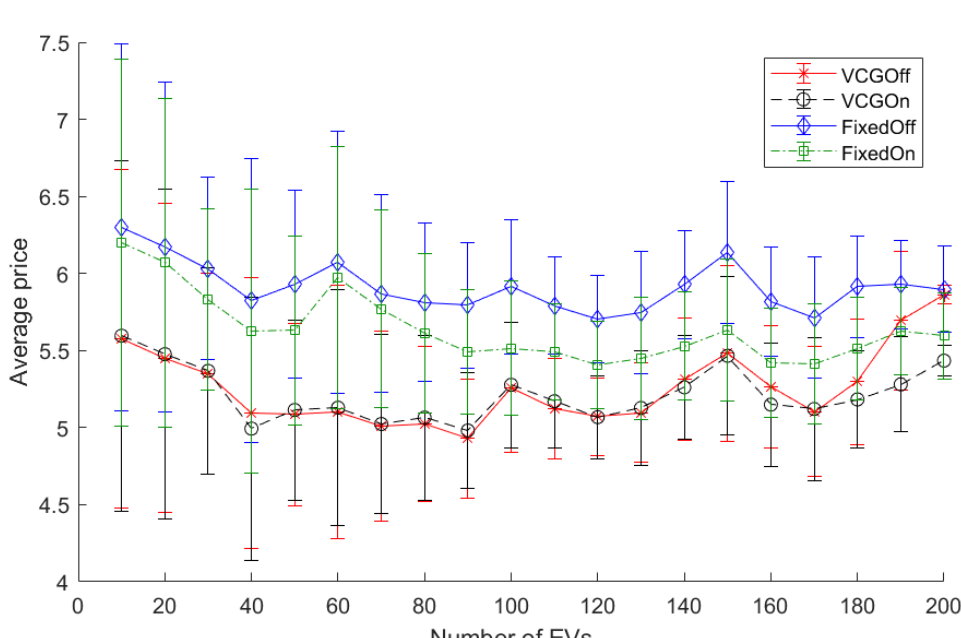
Figure 6. Average price paid by the